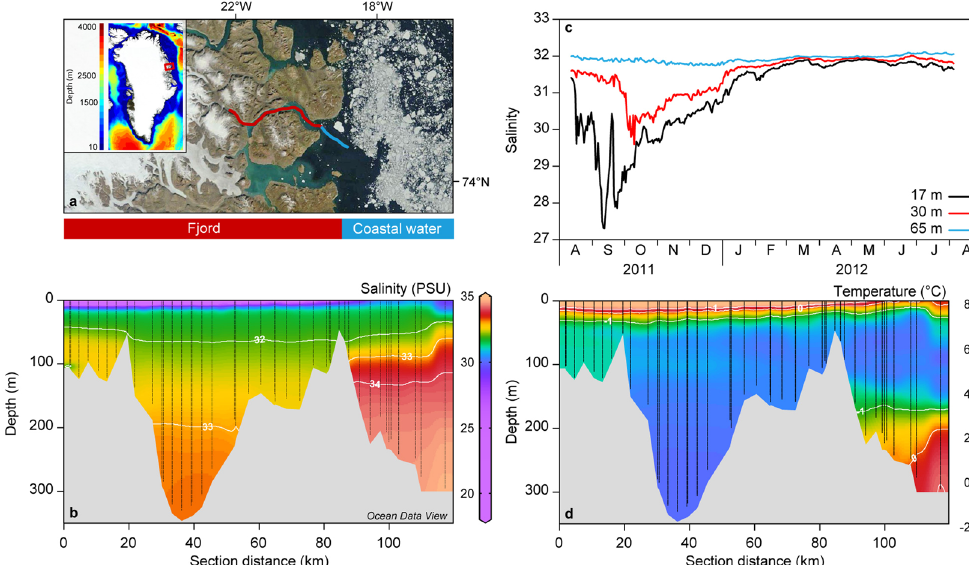
Figure 1. ( a ) Image of the study site in East Greenland with the hydrographical transect sampled from 2003 to 2015. ( b ) Locations of the sampling stations together with distribution in salinity for a typical year (2011). ( c ) Seasonal variability in salinity at three depths from a mooring in the fjord (near the 70 km mark in Fig. 1b) from 2011 to 2012. ( d ) Typical temperatures along the transect in August. Figure 1b and d where created using Ocean Data View version 4.6. http://odv.awi.de. Figure 1a satellite image credit: NASA Goddard Space flight Centre.